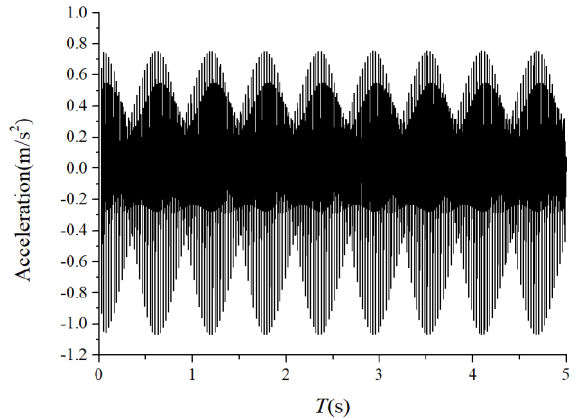
Figure 30. Acceleration envelope spectrum.